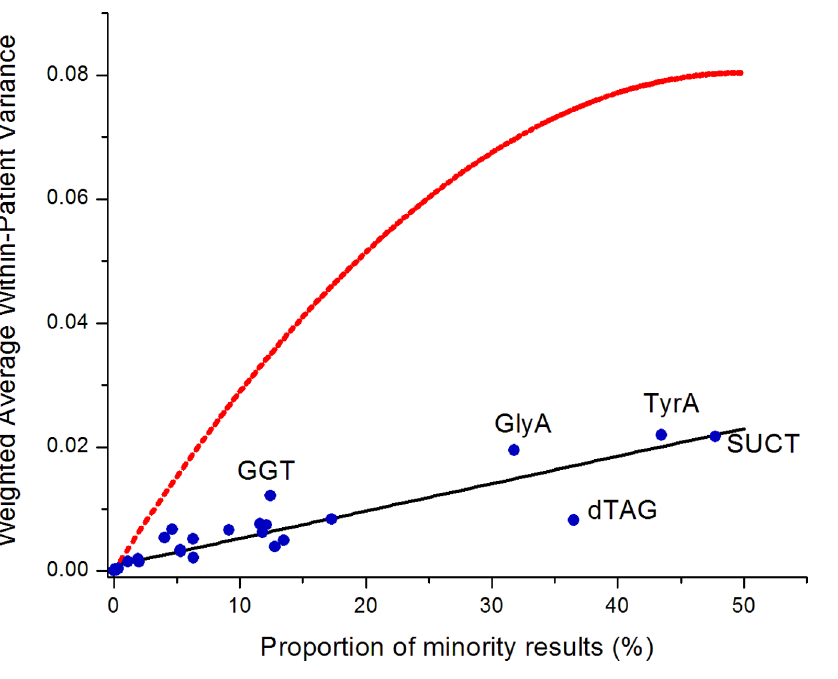
Figure 1. Linear regression (solid line) comparing the observed weighted average within-patient variance by proportion of minority results for 48 biochemical test results. The dashed line represents the theoretical curve that would be expected if there were no correlation between the results of a patient’s first and second isolates of Klebsiella pneumoniae .